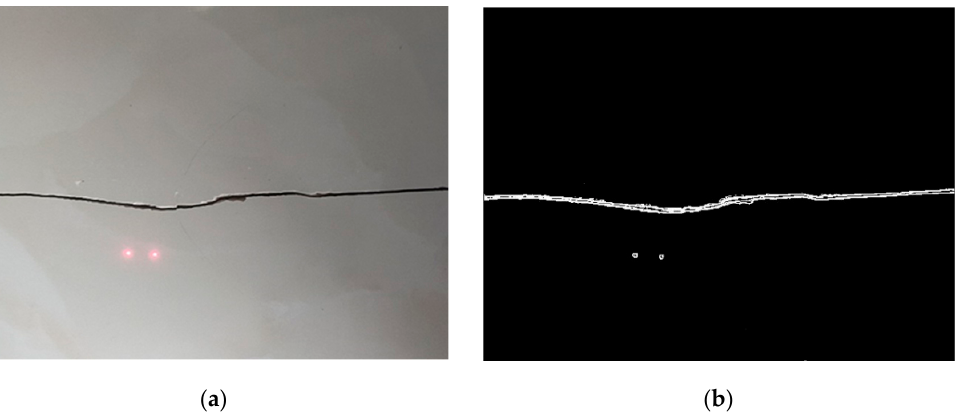
Figure 11. Crack measurement experimental setup.